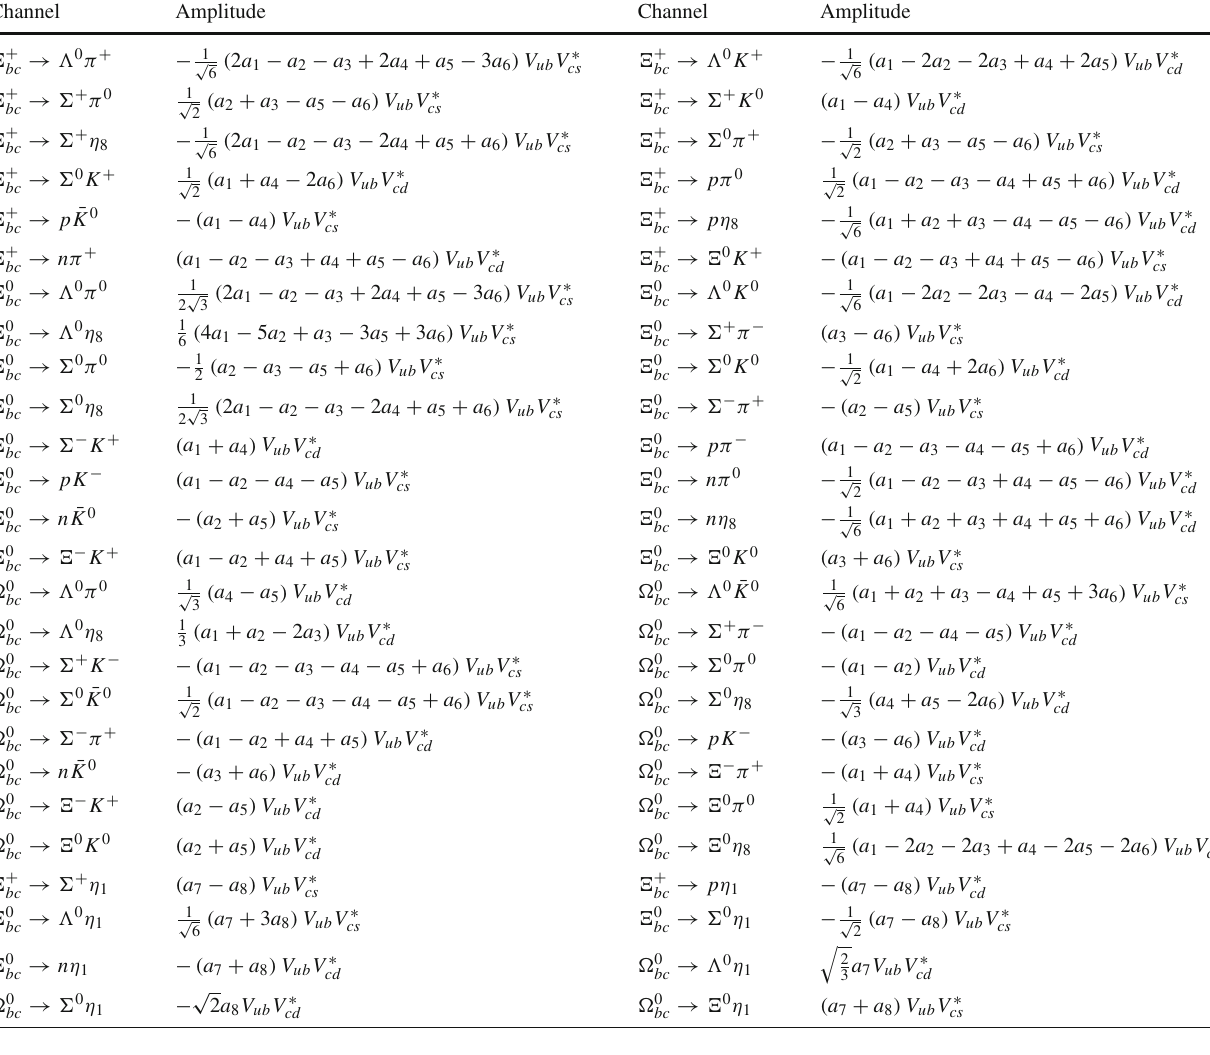
Table 1 Amplitudes for (cid:2) bc and (cid:3) bc decays into a light baryon (octet) and light pseudoscalar meson Channel Amplitude Channel Amplitude (cid:2) + → (cid:4) 0 π bc